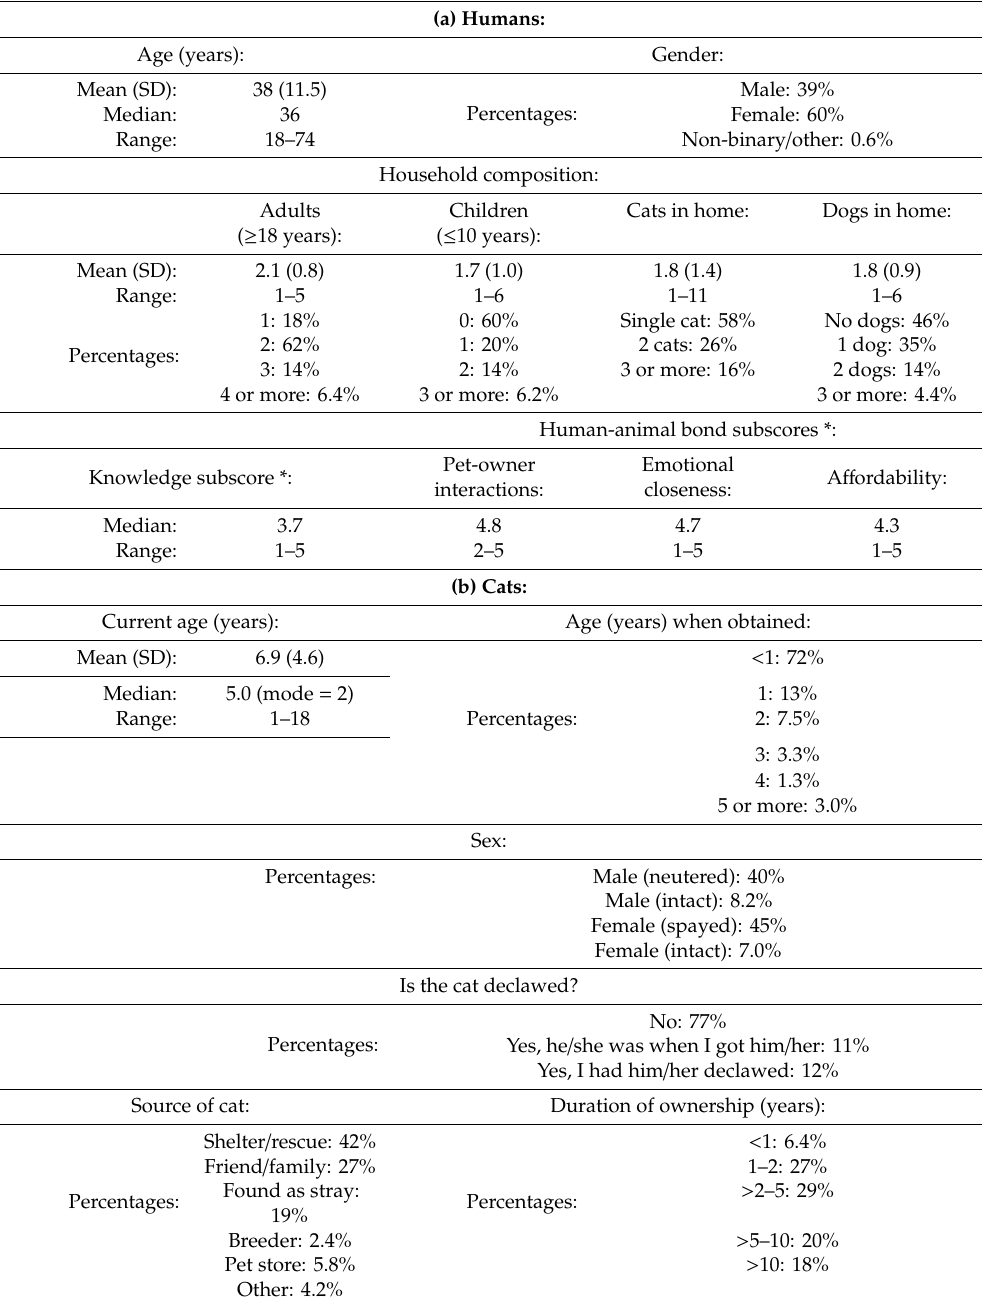
Table 1. Demographic data on U.S. cat owners ( a ) and their cats ( b ) ( n = 547 respondents). For ease of interpretation, results are presented here to two significant